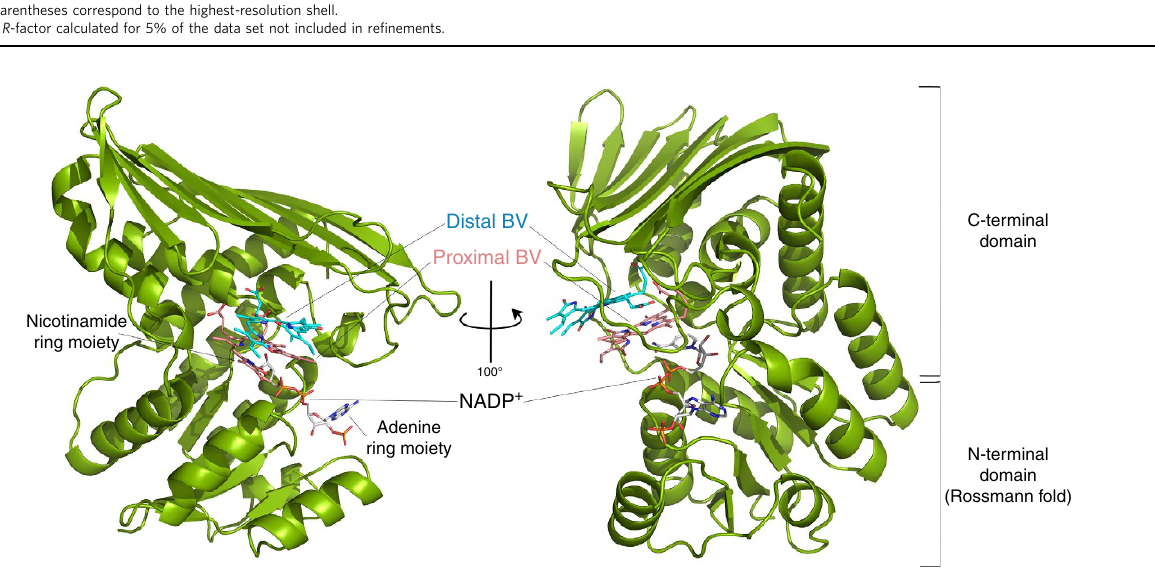
Figure 2 | Overall structure of the Syn BVR complex. Ribbon representation of the crystal structure of Syn BVR in complex with BV and NADP þ . The bound BVs and NADP þ are depicted with sticks. Right, View rotated by 100 (cid:2) about the vertical axis relative to left